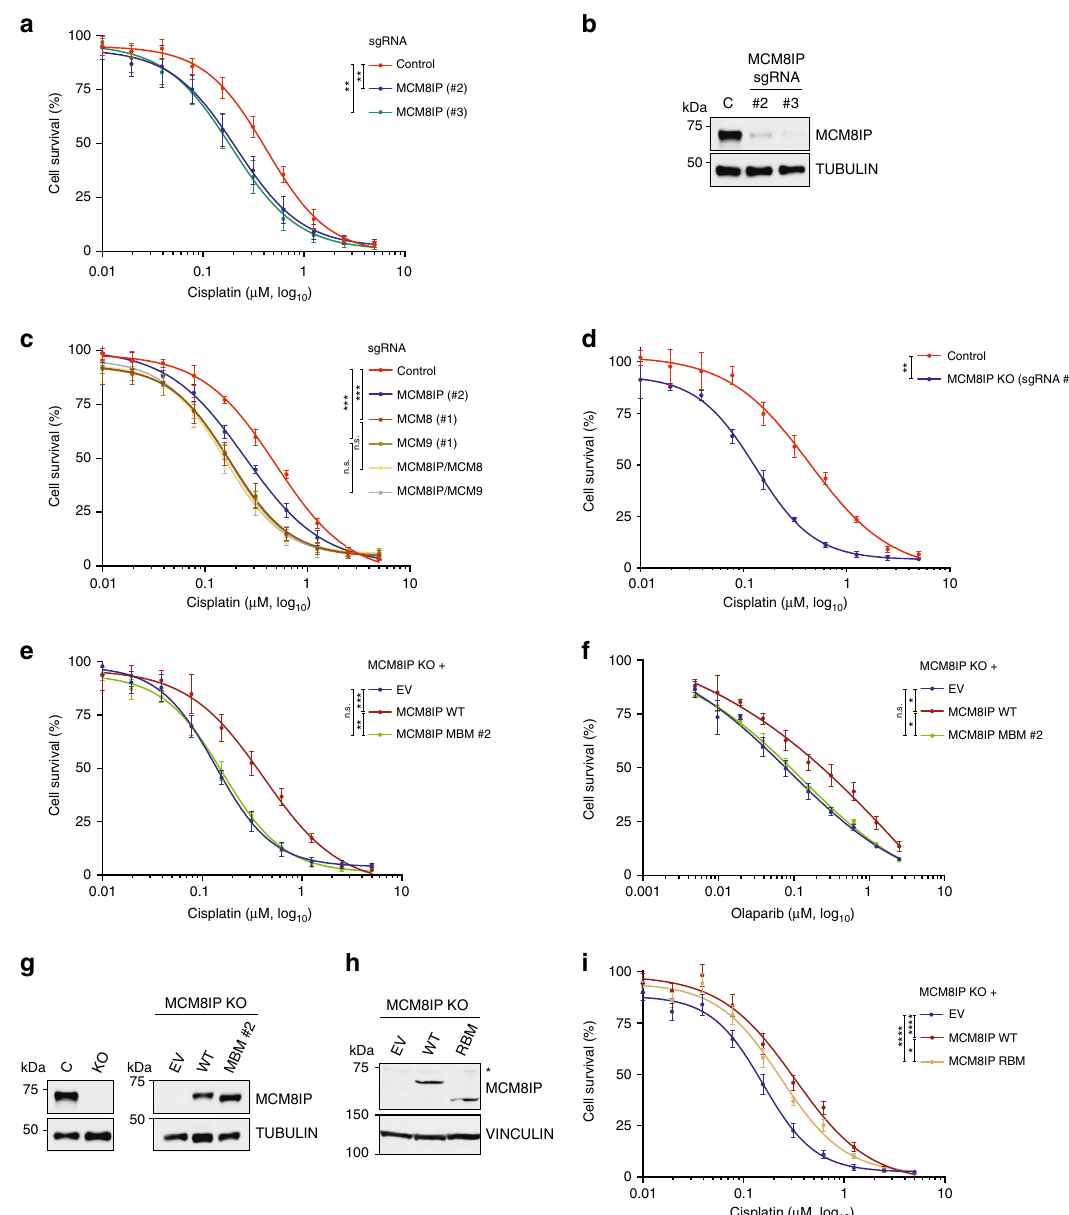
Fig. 6 Survival analysis in MCM8IP-de fi cient cells treated with cisplatin or olaparib. a Survival analysis in HCT116 control cells or cells expressing the indicated MCM8IP sgRNAs upon treatment with cisplatin. Cell survival is expressed as a percentage of an untreated control. The mean ±SD of three independent experiments is presented. Statistical analysis was conducted on data points at three distinct cisplatin concentrations (0.625, 0.313, 0.156 µ M) using Student ’ s t -test (** p < 0.01, at all three concentrations, two-tailed). b Detection by western blot of MCM8IP in HCT116 control cells or cells expressing the indicated MCM8IP sgRNAs utilized in the assay shown in ( a ). Tubulin is shown as a loading control. c Survival analysis of cisplatin-treated HCT116 control cells or cells expressing the indicated sgRNAs. Cell survival is shown as in ( a ). The mean ±SD of three or more independent experiments ( n = 3 – 4) is presented. Statistical analysis was conducted as in ( a ) (*** p < 0.001, at all three concentrations analyzed). d Survival analysis of HCT116 control cells or an HCT116 MCM8IP KO clone in response to cisplatin. Cell survival is represented as in ( a ). The mean ±SD of three independent experiments is presented. Statistical analysis was conducted as in ( a ) (** p <0.01, at all three concentrations analyzed). e Survival analysis in the HCT116 MCM8IP KO clone shown in ( g ) reconstituted with MCM8IP WT, MBM #2, or an empty vector (EV) control in response to cisplatin. Cell survival is shown as in ( a ). The mean ±SD of four independent experiments is presented. Statistical analysis was conducted as in ( a ) (** p < 0.01, *** p < 0.001, at all three concentrations analyzed). f Survival analysis in the HCT116 MCM8IP KO clone shown in ( g ) reconstituted with MCM8IP WT, MBM #2, or an EV control in response to olaparib. Cell survival is represented as in ( a ). The mean± SD of three independent experiments is presented. Statistical analysis was conducted on data points at three distinct olaparib concentrations (0.313, 0.156, 0.078 µ M) as in ( a ) (* p < 0.05, at all three concentrations). g Detection by western blot of MCM8IP in HCT116 control cells or in an MCM8IP KO clone (left panel), and in the same MCM8IP KO clone reconstituted with MCM8IP WT, MBM #2, or an EV control (right panel). Tubulin is shown as a loading control. h Detection by western blot of MCM8IP in an HCT116 MCM8IP KO clone reconstituted with MCM8IP WT, RBM, or an EV control. Vinculin is shown as a loading control. Asterisk indicates a non-speci fi c band. i Survival analysis in the HCT116 MCM8IP KO clone shown in ( h ) reconstituted with MCM8IP WT, RBM, or an EV control in response to cisplatin. Cell survival is shown as in ( a ). The mean± SD of nine independent experiments is presented. Statistical analysis was conducted as in ( a ) (* p < 0.05, **** p < 0.0001, at all three concentrations